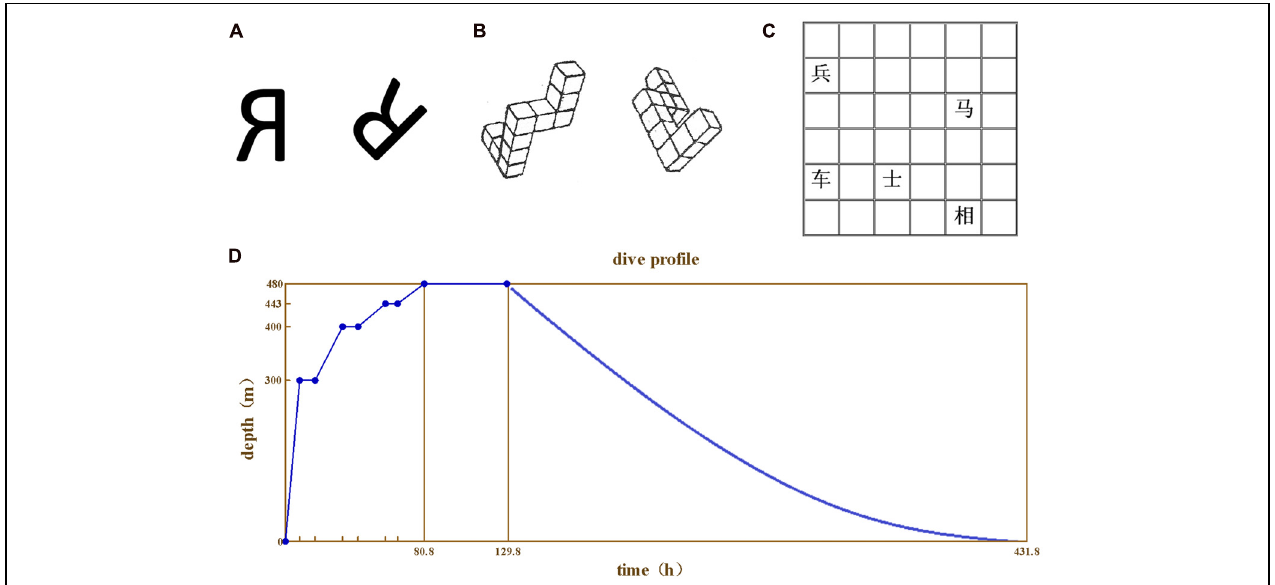
FIGURE 1 | The test materials and the compression procedure. (A) 2D mental rotation, (B) 3D mental rotation, (C) Spatial memory test, (D) The compression and depression procedures.